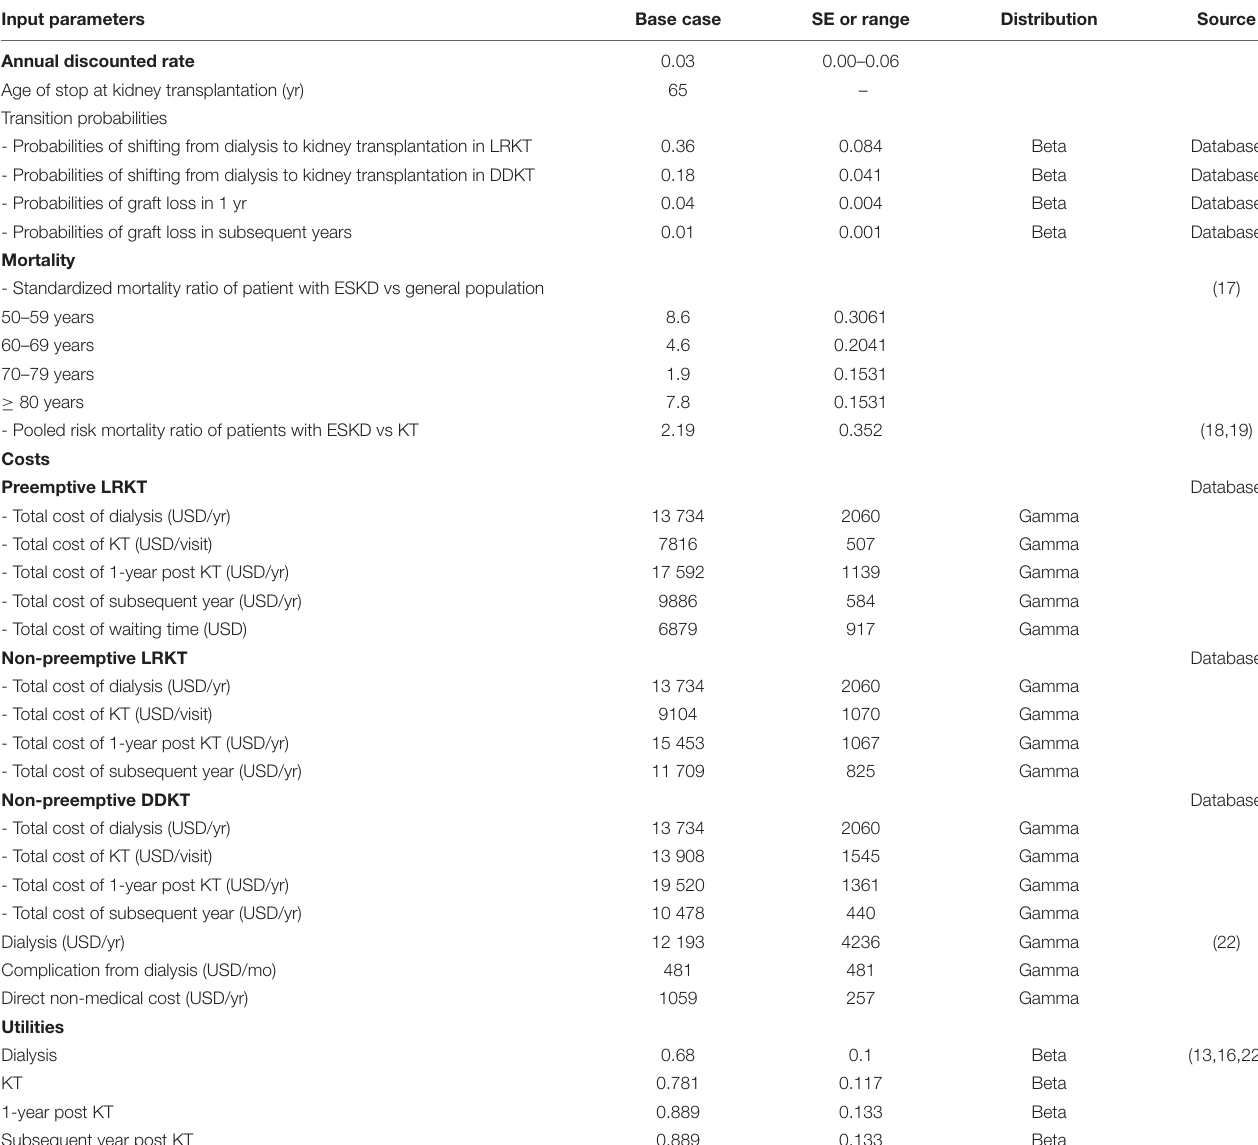
TABLE 1 | Input parameters of